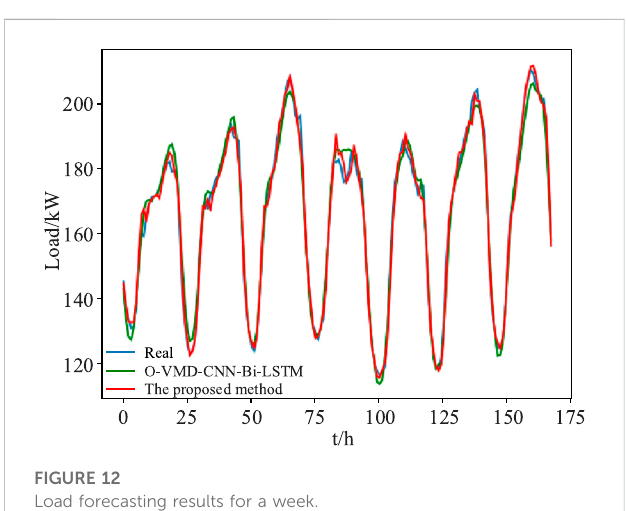
FIGURE 12 Load forecasting results for a